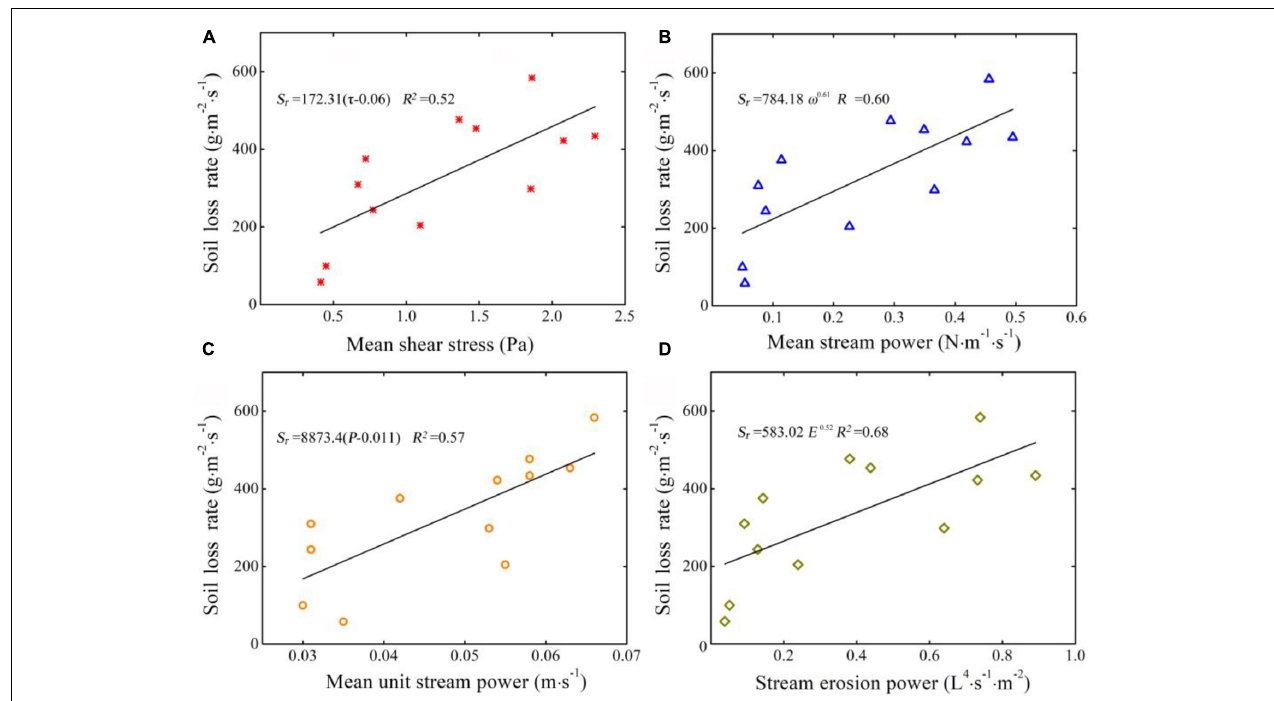
FIGURE 4 | The relationships between the soil loss rate and the mean shear stress (A) , mean stream power (B) , mean unit stream power (C) and stream erosion power (D) .